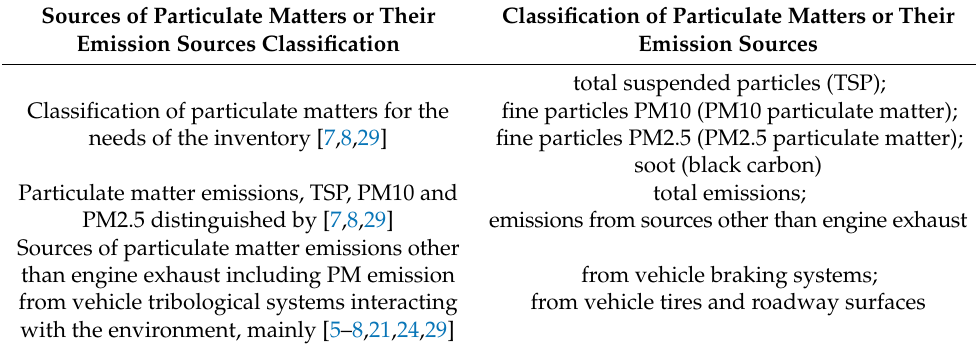
Classification of Particulate Matters or Their Emission Sources total suspended particles (TSP); total emissions;